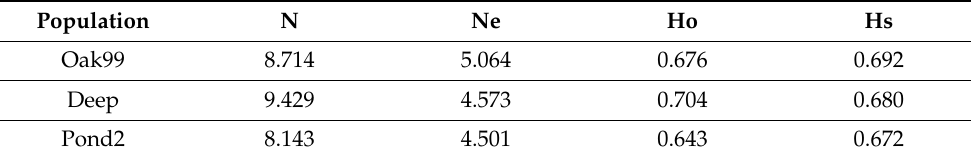
Table 1. Genetic diversity estimates of the three focal ponds for Ambystoma opacum in the Maple Flats Sinkhole Complex.